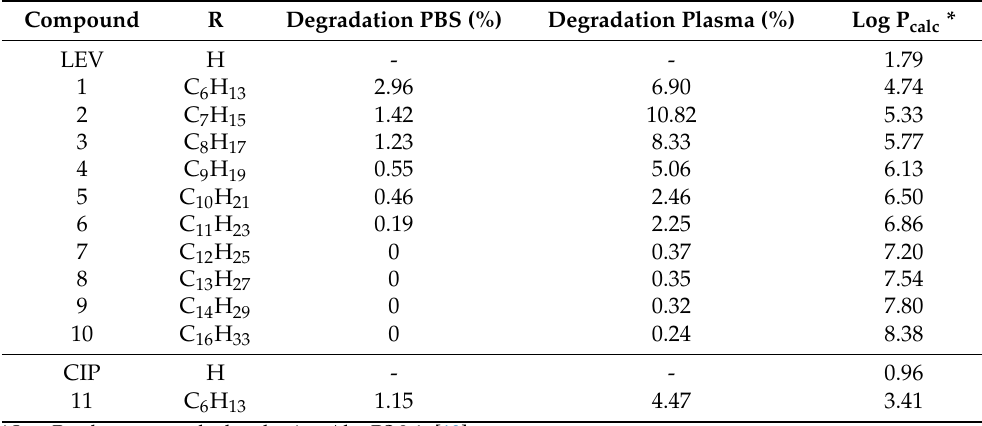
Table 1. Results obtained from the ester degradation percentage values, after 14 days in phosphate buffer (PBS) and after 3 days in human plasma; comparison with lipophilicity (log P).